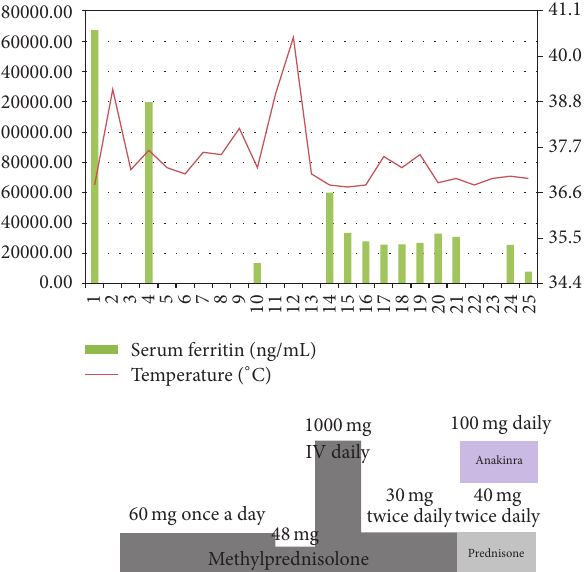
Figure 2: Serum ferritin levels and temperature charting along with the